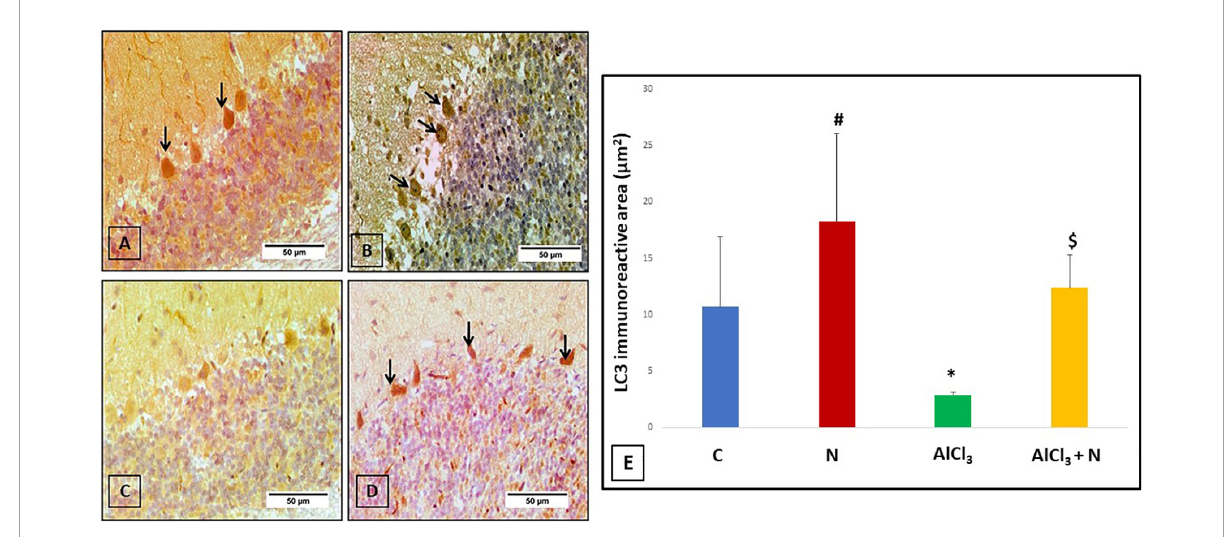
FIGURE9 Immunohistochemical detection of cerebellar LC3: (A,B) C and N groups, respectively showed strong positive LC3 immunostaining in most of the Purkinje cells (arrows). (C) AlCl 3 group showed strong negative LC3 immunostaining. (D) AlCl 3 + N treated group showed weak positive immunostaining for LC3 in some Purkinje cells (arrows) (LC3 × 400). (E) Area% of LC3 positive immune reaction in cerebellar sections of all studied groups. n = 6 in each group. Data were prescribed as mean ± SD . The intergroup variation was conducted by Games-Howell post-hoc test. ∗ p = 0.008 compared with C group. # p < 0.001 compared with AlCl 3 . $ p < 0.001 compared with AlCl 3